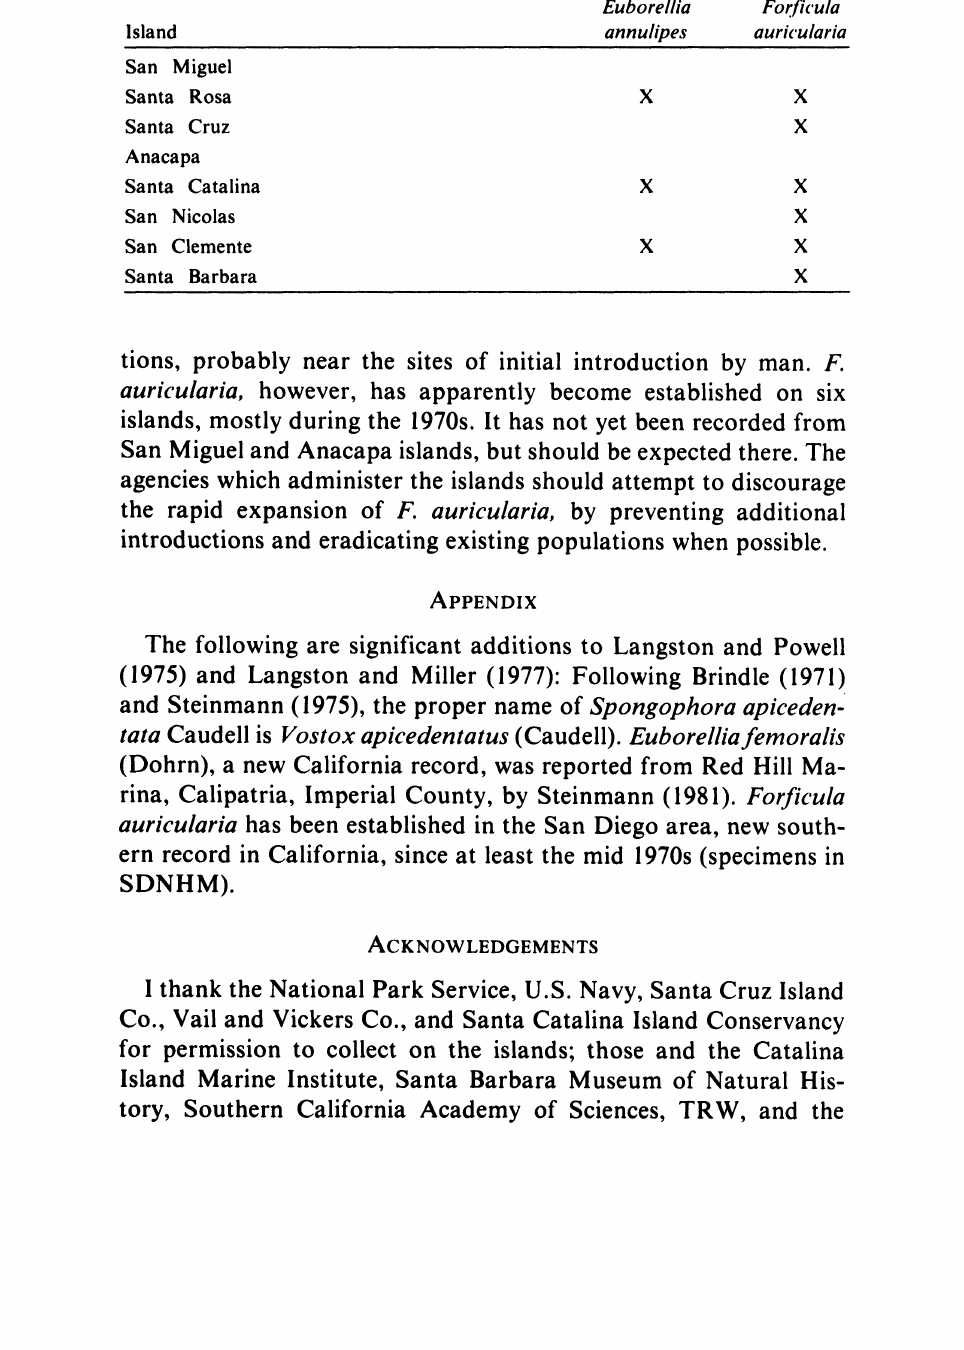
Table I. Summary of earwig distribution on the California Channel